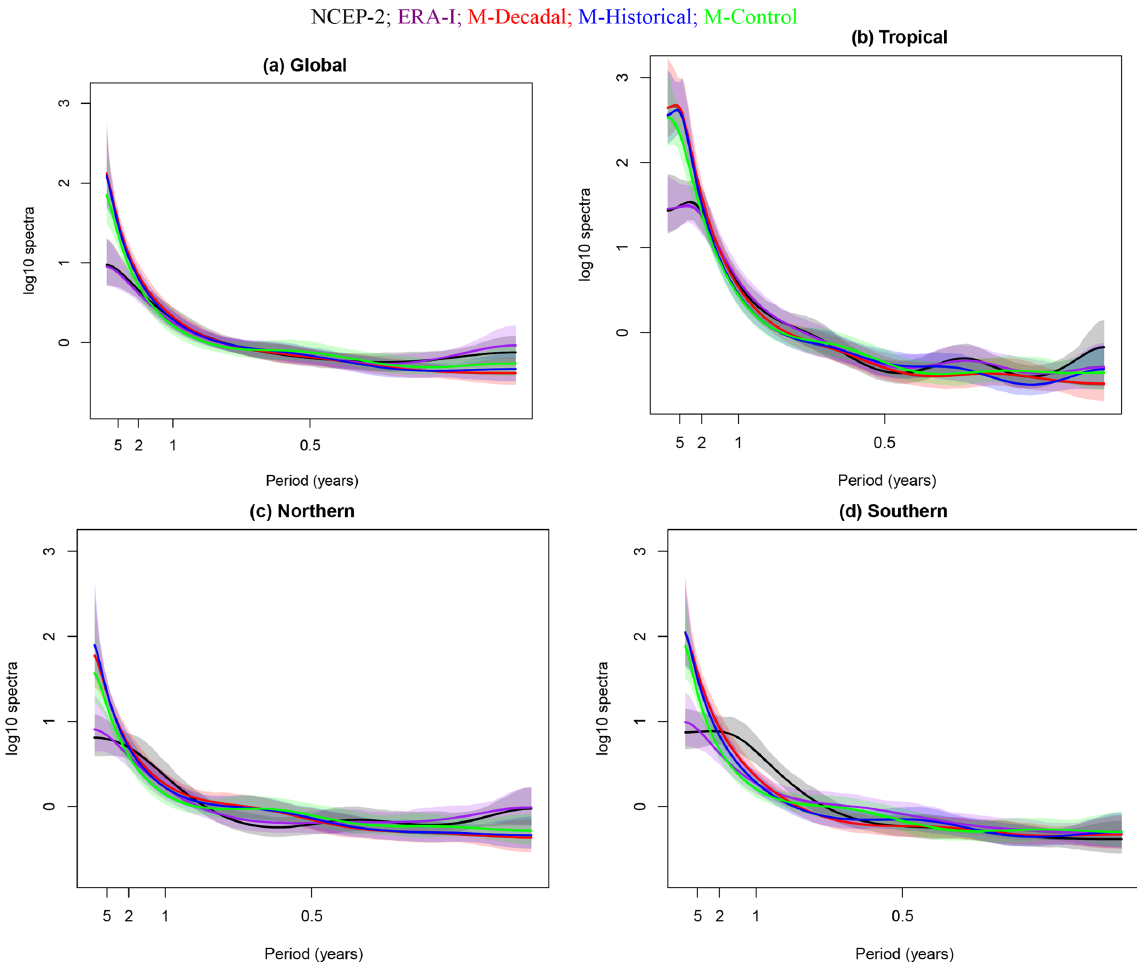
Figure 4. MAP AR log 10 spectra normalized with respect to white noise for each climate simulation by region with the 95% posterior inter- vals shaded. Instead of the frequency ω , the x axis is labeled at select years (2 π/ 12 ω ). Different line colors denote the type of simulation and the reanalysis product. The top panels represent global (a) and tropical (b) regions; the bottom panels represent the Northern Hemisphere (c) and Southern Hemisphere (d)